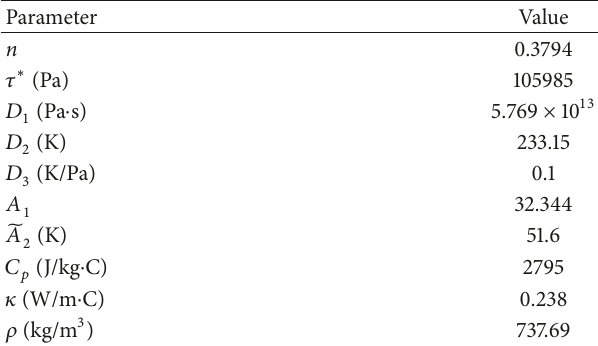
Table 3: Property parameters of